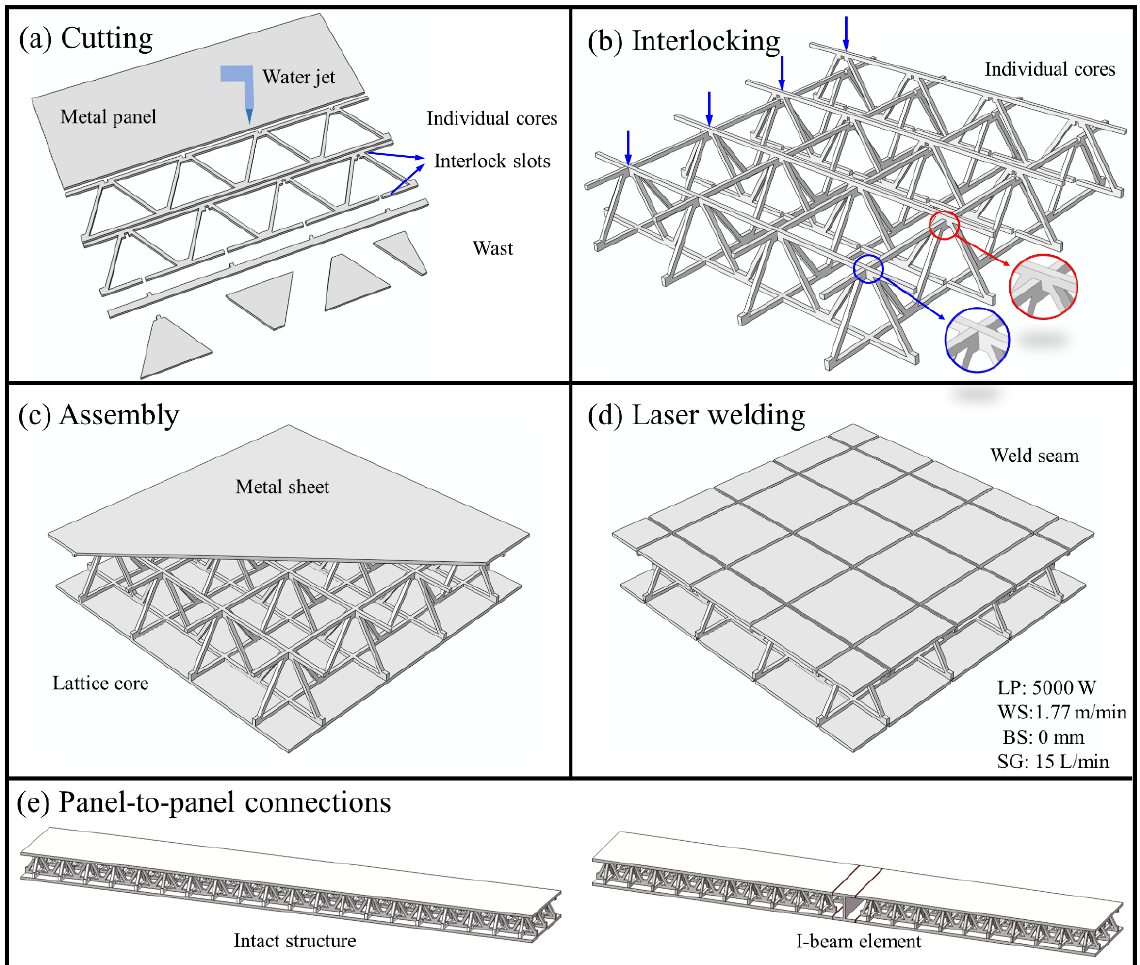
Figure 3. Fabricating process of panel-to-panel LTPSs: ( a ) cutting metal sheets and individual cores, ( b ) individual cores connected by interlock, ( c ) assembly inner cores and metal sheet, ( d ) connection by laser welding, ( e ) manufactured large-size LTPSs: intact structure and I-beam element connected structure.